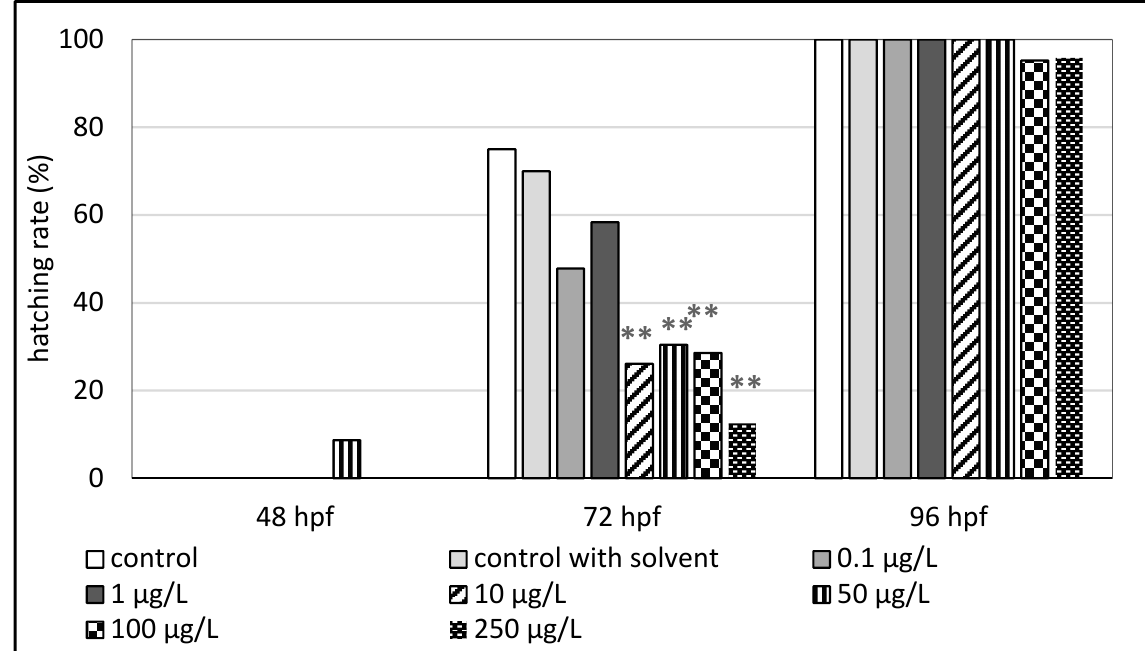
Figure 2. Hatching rate (%) of zebrafish embryos exposed to octocrylene (hpf—hours post fertiliza- tion). The asterisk indicates a significant difference (* p < 0.05) between the control and experimental groups at the same time of exposure.